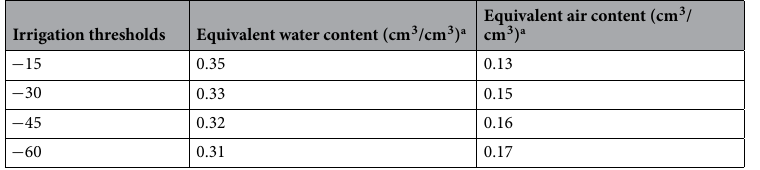
Table 2. Volumetric soil water and air content (cm 3 /cm 3 ) for each irrigation threshold. a Calculated with the van Guenuchten equation 47